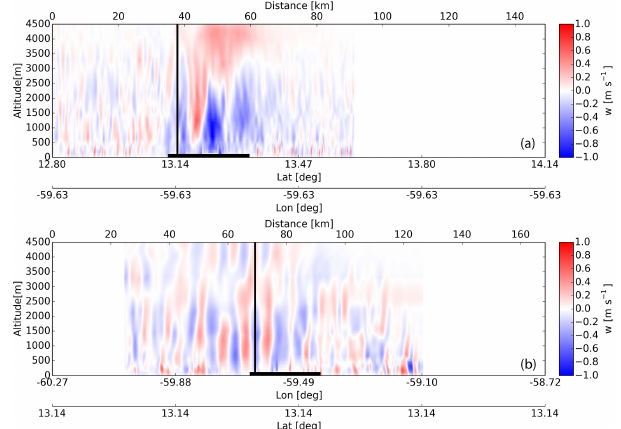
Figure 16. Vertical wind speed from the LES for 26 June at 20:00LT for leg 1 (upper panel) and 22:00LT for leg 2 (lower panel). The location of Barbados is indicated as a horizontal black segment, while the intersection between legs 1 and 2 is indicated with a vertical